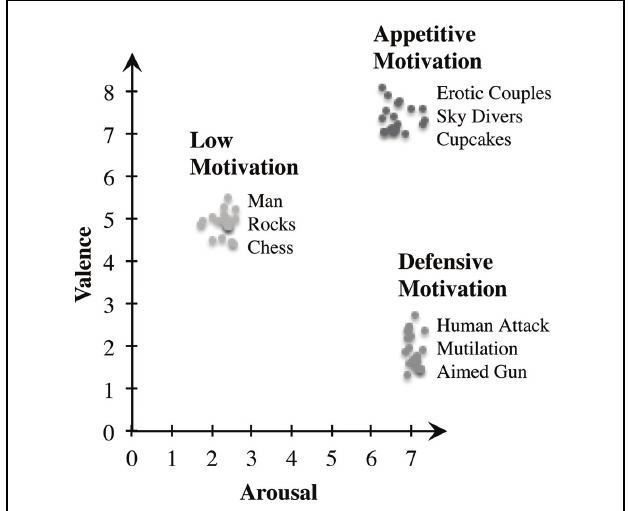
FIGURE 1 | Ratings of the scenes from the International Affective Picture System (IAPS). The y -axis displays mean pleasure, the x -axis displays mean arousal. Ratings of the 20 images per condition are noted, as well as three examples of each presented category. Along the trajectories of appetitive and defensive motivation, the selected pictures are positioned at the end of the respective line (Lang et al.,